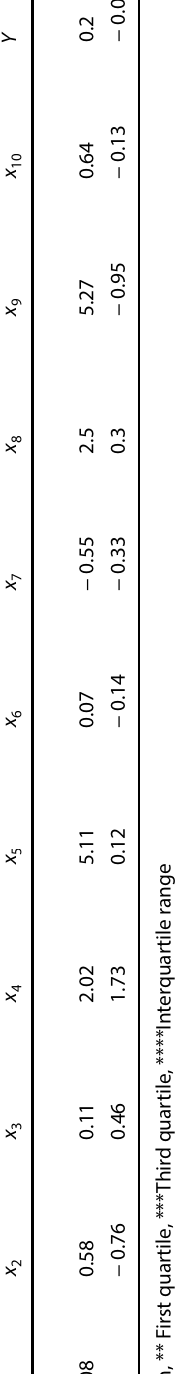
Table 7 Results of model fitting on the first interval Model